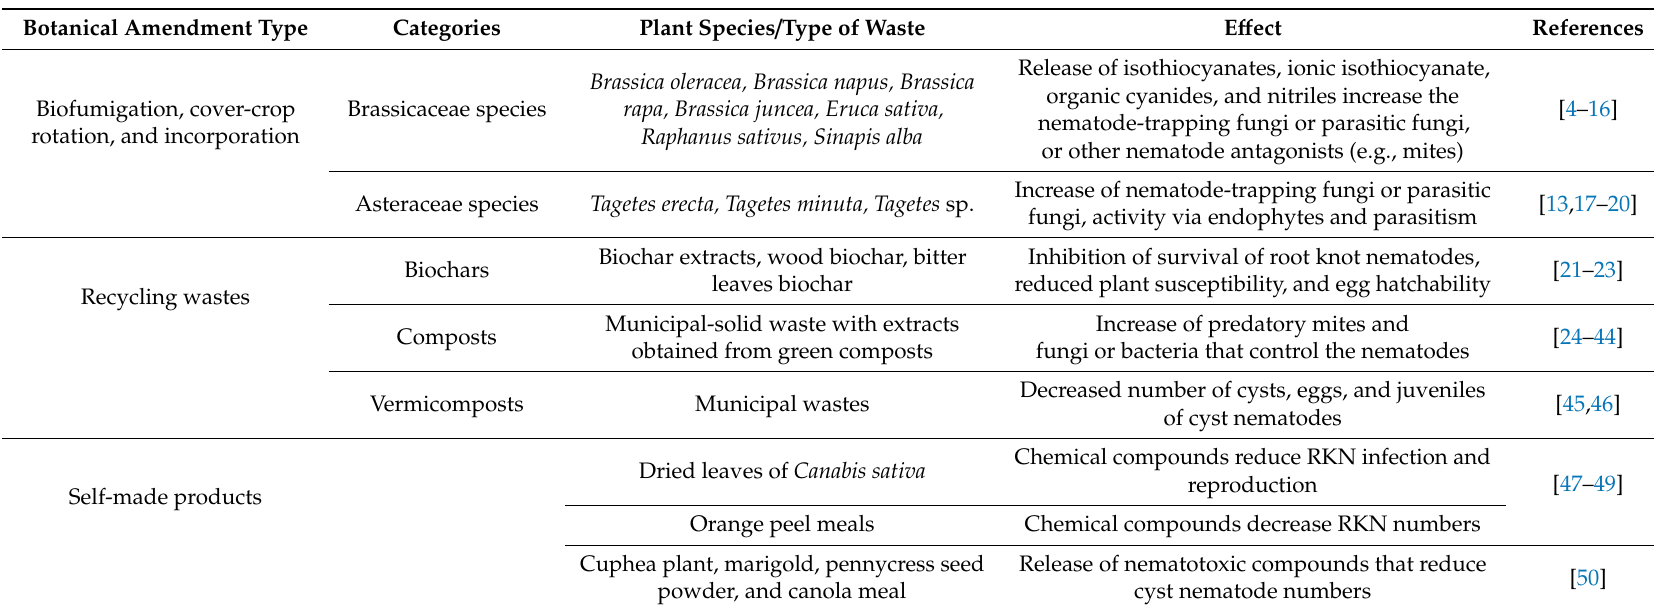
Table 1. Main groups of nematode-suppressive amendments with related e ff ects and